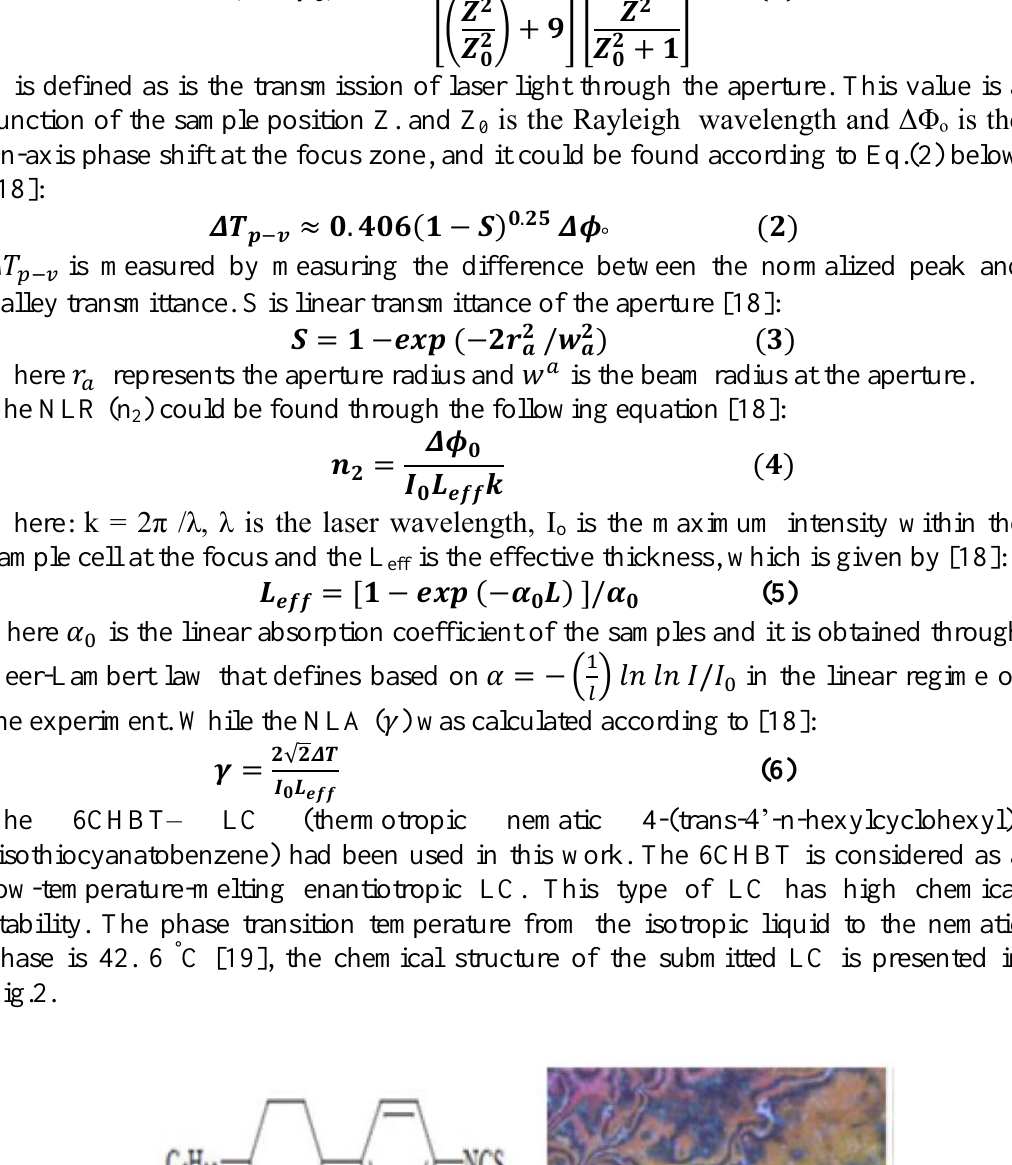
O NP’s coated with 3 4